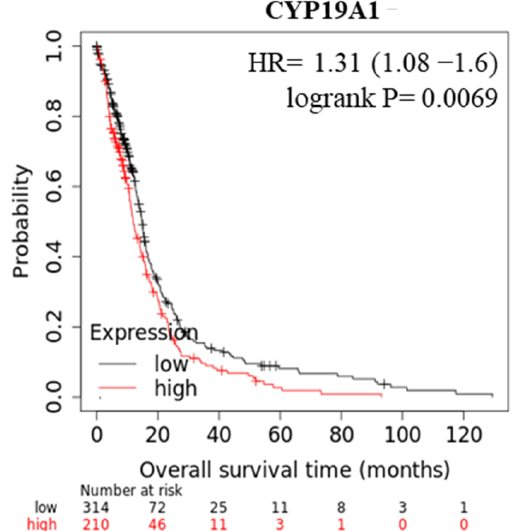
Figure 6. Aromatase and clinical outcomes in GBM patients. Kaplan–Meier survival analysis relating CYP19A1 levels and overall survival (OS) in GBM patients (TCGA dataset).